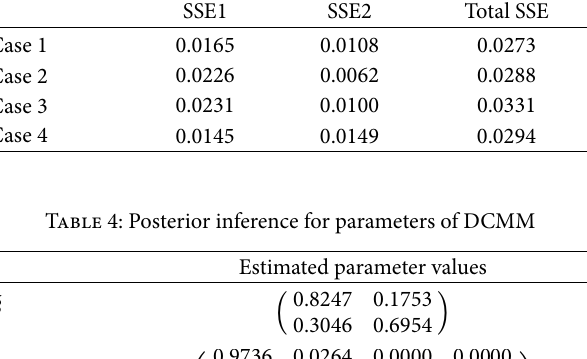
Table 3: SSE of four cases with different parameters. SSE1 SSE2